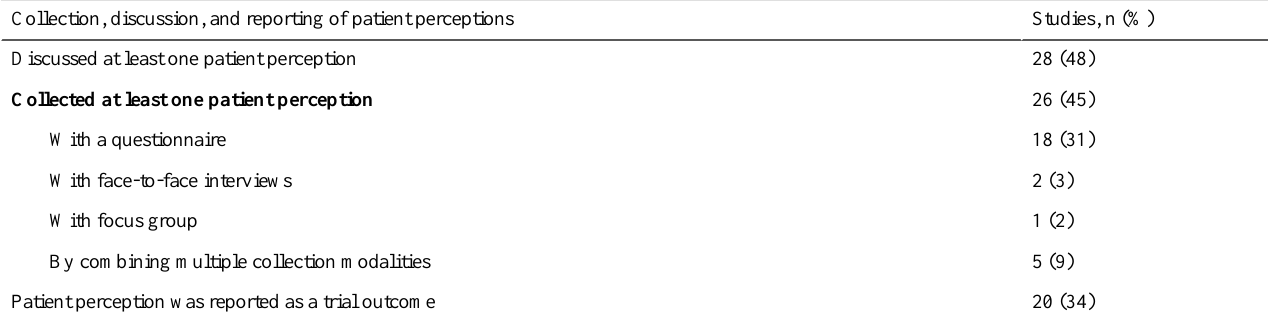
Table 2. Collection, discussion, and reporting of patient perceptions toward biometric monitoring devices in the 58 included